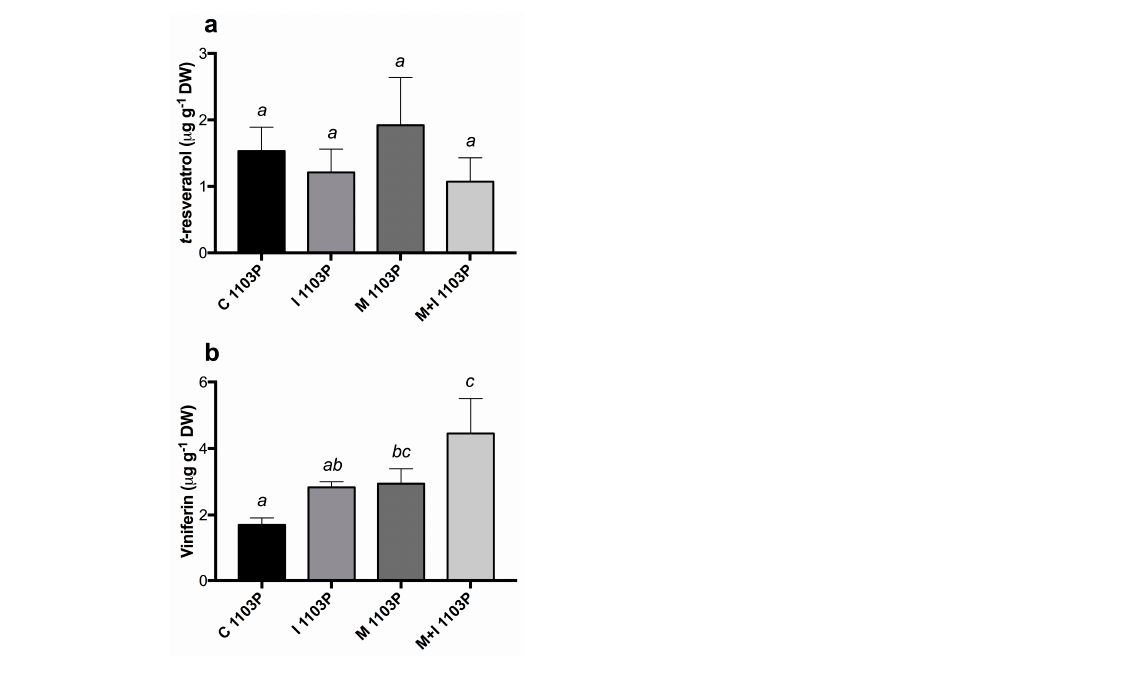
Figure 6. Stilbenes concentration in leaf tissues of ‘Glera’ plants grafted onto 1103P rootstock. ( a ) t -resveratrol quantification and ( b ) Viniferin quantification. Data are expressed as mean ± SD ( n = 10) of randomly selected plants over 2020 and 2021 seasons. Different lowercase letters above the bars indicate significant differences according to Tukey’s HSD test ( p < 0.05). C, control plants; I, Inducer-treated plants; M, AMF mixed inoculum-treated plants; M+I AMF mixed inoculum + Inducer-treated plants.